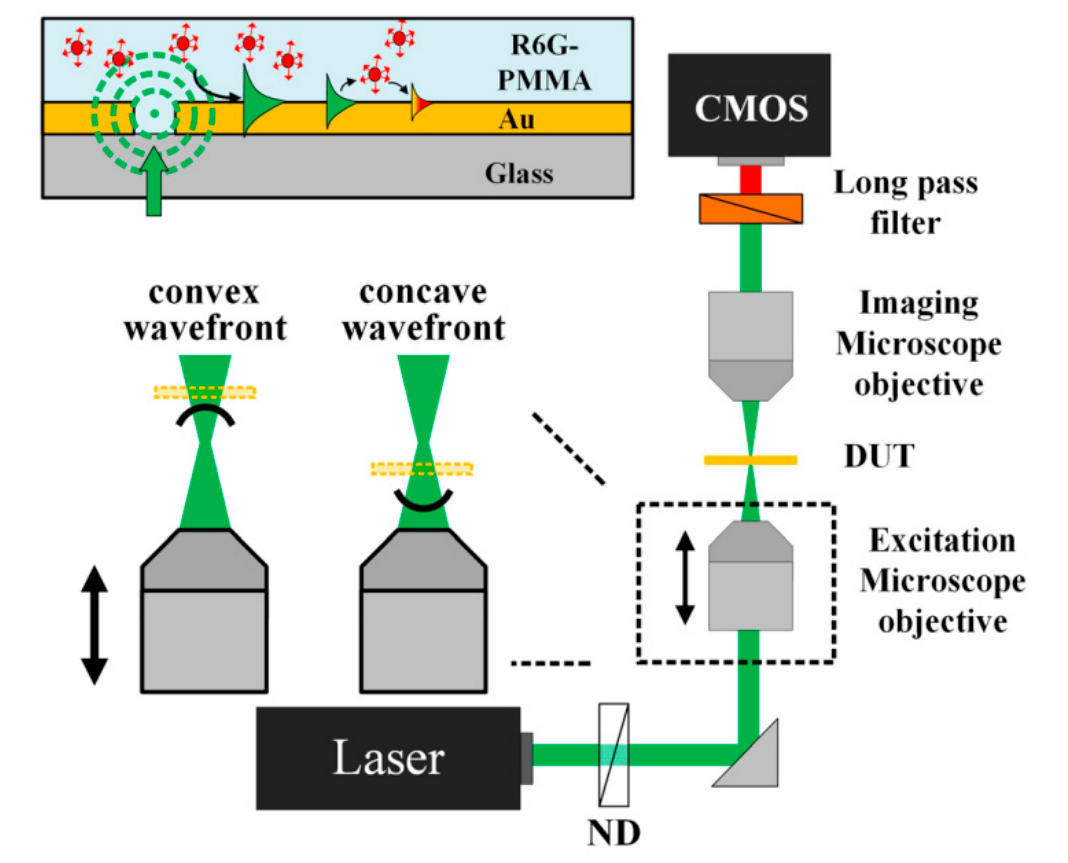
Figure 25. The confocal configuration used to measure the shift in the focal spot. ND is a Neutral Density filter and DUT is the Device Under Test. Figure reprinted from Ref. [128] Charles Pelzman and Sang-Yeon Cho, “Wavefront detection using curved nanoscale apertures”, Applied Physics Letters 114, 183103 (2019), with the permission of AIP Publishing.